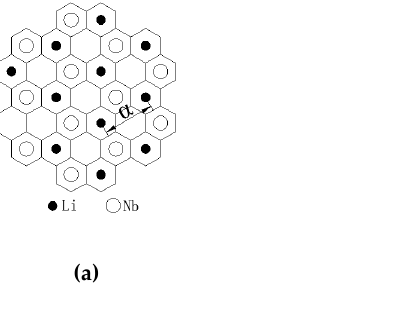
Figure 8. Schematic illustration of atomic structure of LN:( a ) Z-cut, ( b ) X-cut